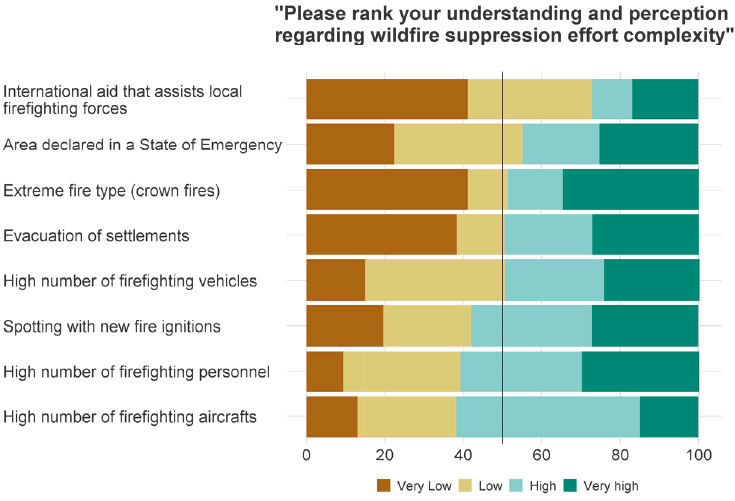
Figure 4. Likert scale ranking of factors that affect wildfire suppression complexity as percentages of survey responses.